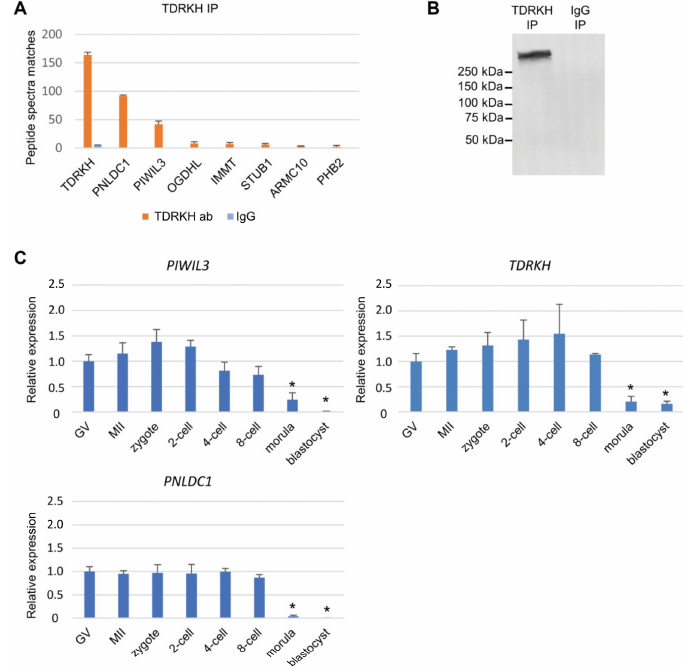
Figure 3. PIWIL3 forms a complex with TDRKH and poly(A)-specific ribonuclease-like domain containing 1 (PNLDC1) in oocytes. ( A ) Identification of TDRKH-associated proteins by mass spectrometry. Orange: TDRKH immunoprecipitation (IP). Blue: IgG IP (negative control). ( B ) Crosslinked TDRKH complexes. Chemically crosslinked TDRKH complexes detected as a > 250 kDa band by Western blotting. ( C ) Bar graph showing PIWIL3 , TDRKH , and PNLDC1 mRNA expression as detected by quantitative reverse transcription- polymerase chain reaction (qRT-PCR) in oocytes and early stage embryos. * p <